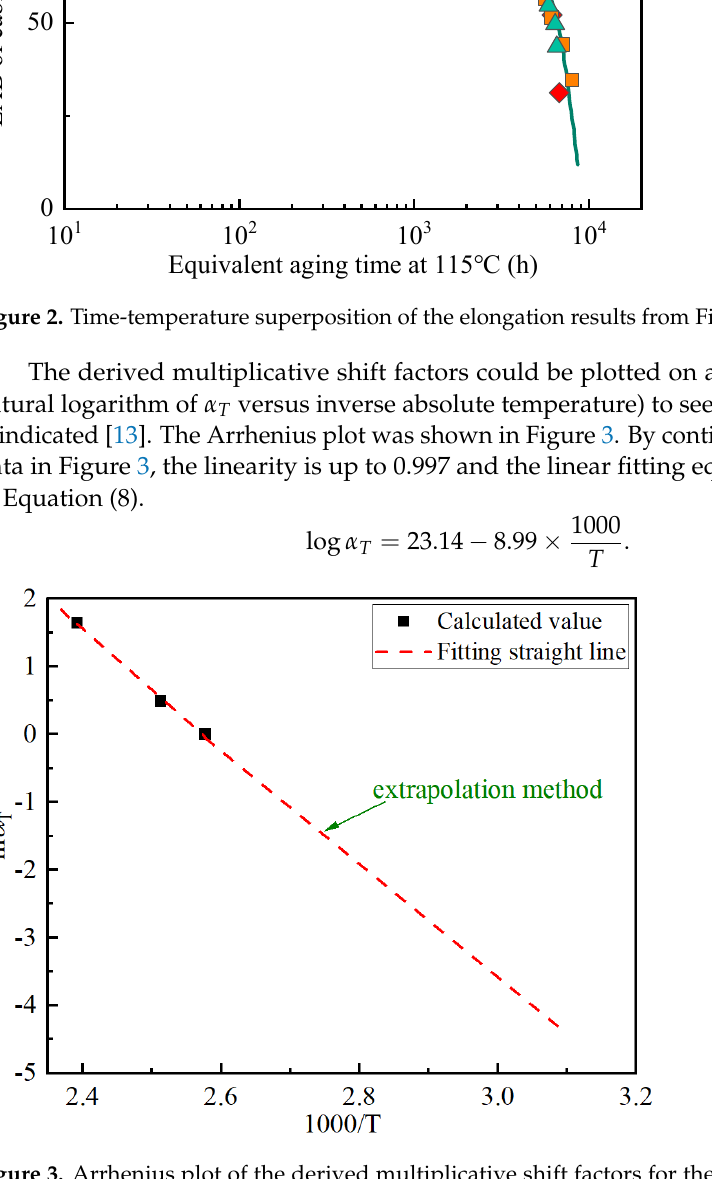
Figure 3. Arrhenius plot of the derived multiplicative shift factors for the EAB of slice samples of XLPE cable insulation.